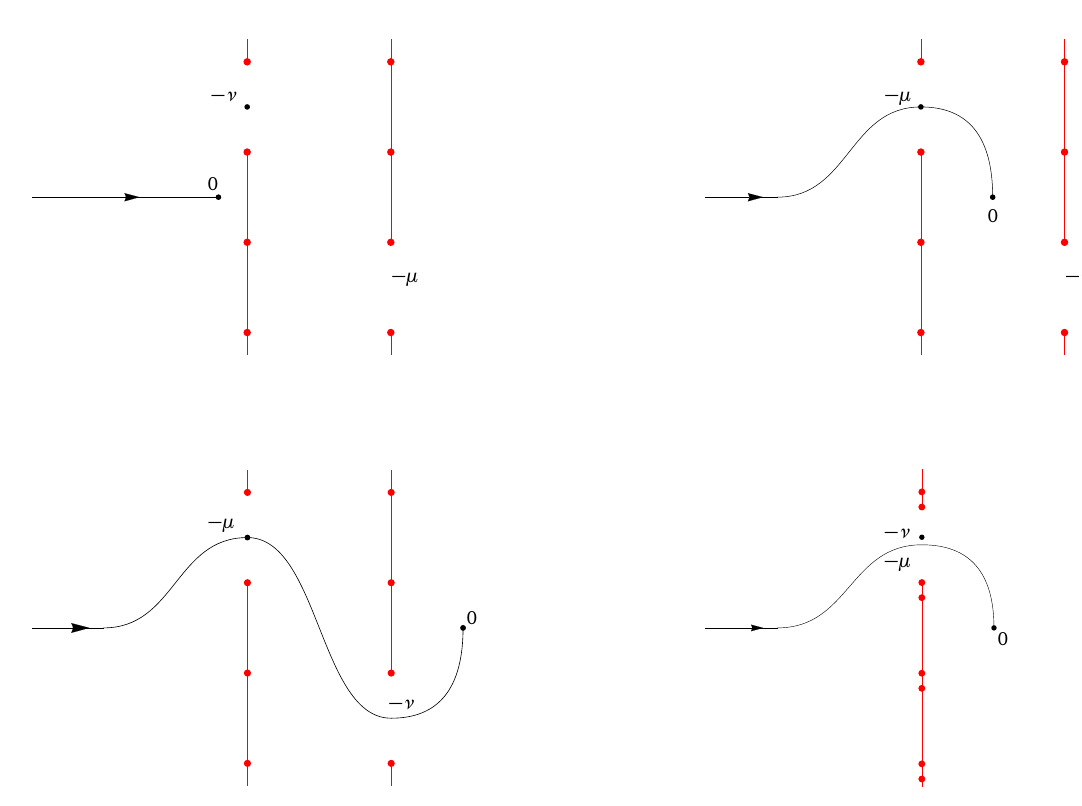
Figure 22: Possible choices for the path of integration in the definition (101) for K . The red, vertical lines are the branch cuts in the variable u of χ (cid:48)(cid:48) P , Q χ (cid:48)(cid:48) ( u + µ ) , and the red dots on the cuts are the associated branch points − ν + 2i π a , Q − µ + 2i π a , a ∈ (cid:90) + 1 / 2. The black curves, ending at u = 0, represent the path for the variable u . From left to right, top to bottom, the four graphs represent respectively the situations Re µ < Re ν < 0; Re ν < 0 < Re µ ; Re µ > Re ν > 0; Re ν = Re µ > 0 with − π < Im ( ν − µ ) < π